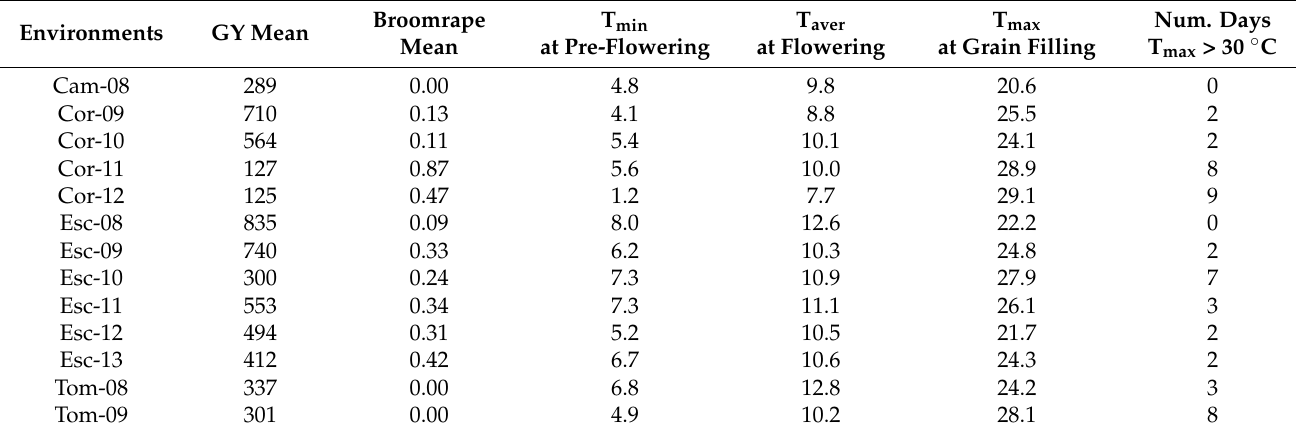
Table 8. Description by environment of the major drivers on yield: levels of broomrape infection, T min at pre-flowering, T aver at flowering, T aver at grain filling, and number of days with T max > 30 ◦ C at grain filling.